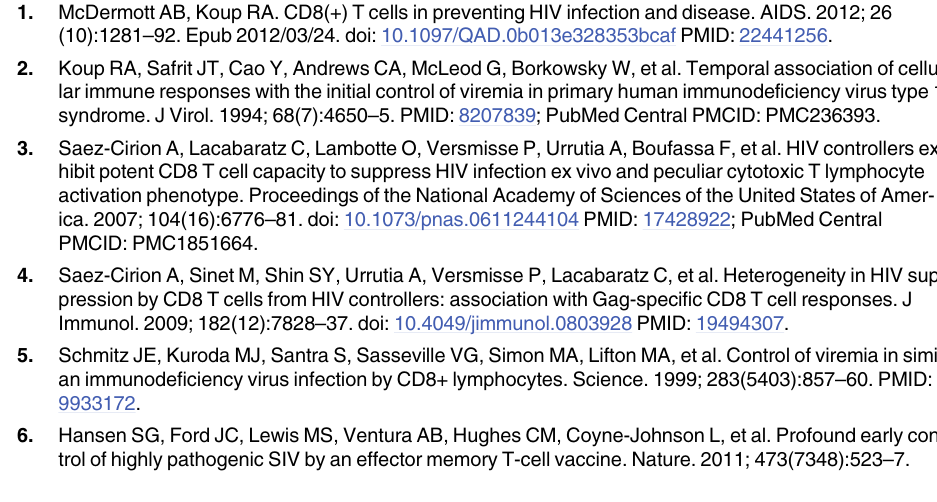
trolled, randomized trial in HIV-uninfected, healthy adult volunteers to evaluate the safety and immunogenicity of F4Co adjuvanted AS01B or AS01E administered with